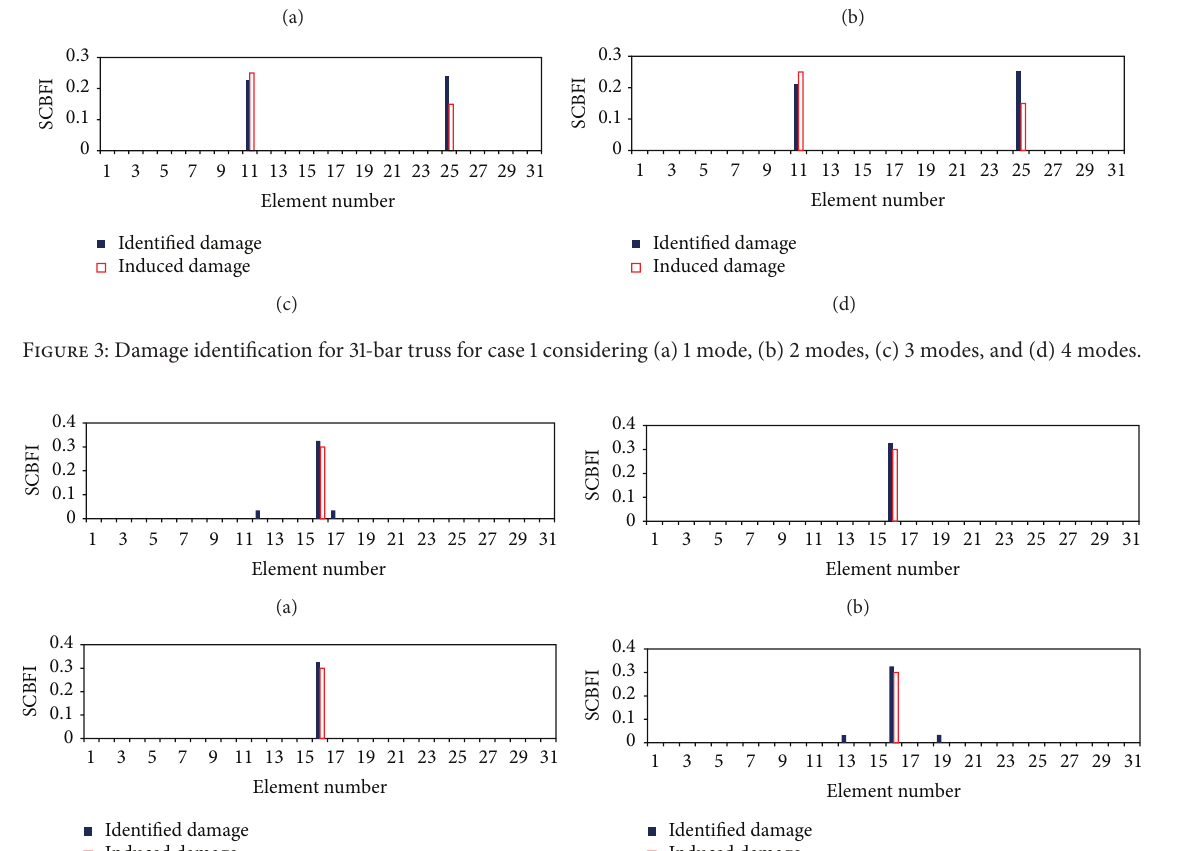
So, at the next step, the strain of e th element for 𝑖 th column of healthy and damaged structure based on the columnar coefficients of the flexibility matrix can be deter- mined as